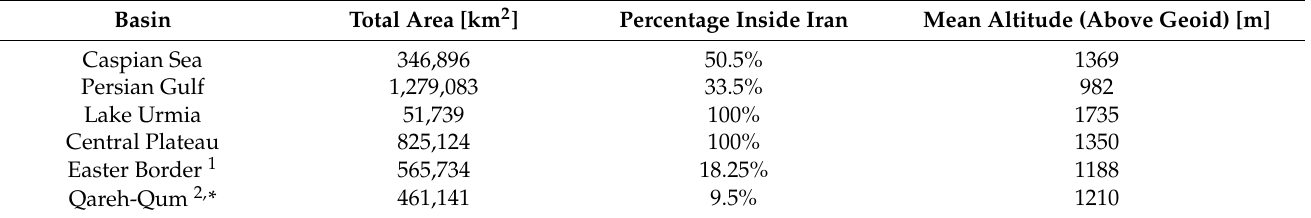
Figure 1. Study Area: ( a ) location of Iran, ( b ) geographical position of Iran’s basins and 31 provinces, ( c ) 90 m DEM (above Geoid), ( d ) 32-year mean precipitation rate (1990–2021), and ( e ) 32-year mean NDVI (1990–2021). Table 1. Iran’s water basins. Table 1. Iran’s water basins.